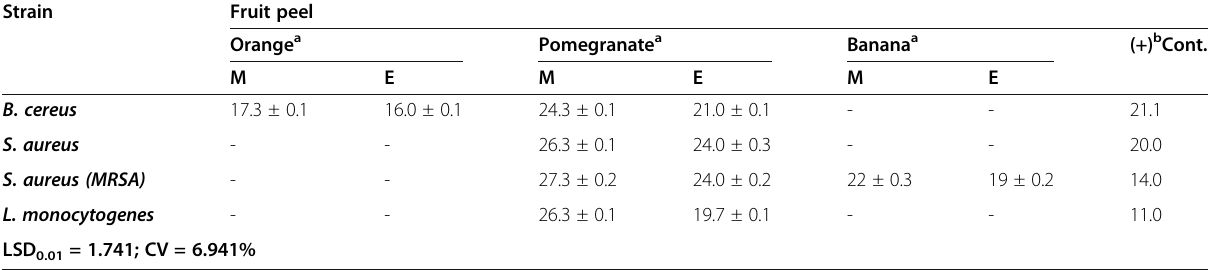
Table 1 Inhibition zones of both methanolic and ethanolic extracts of the used fruit peels against some G + food pathogens